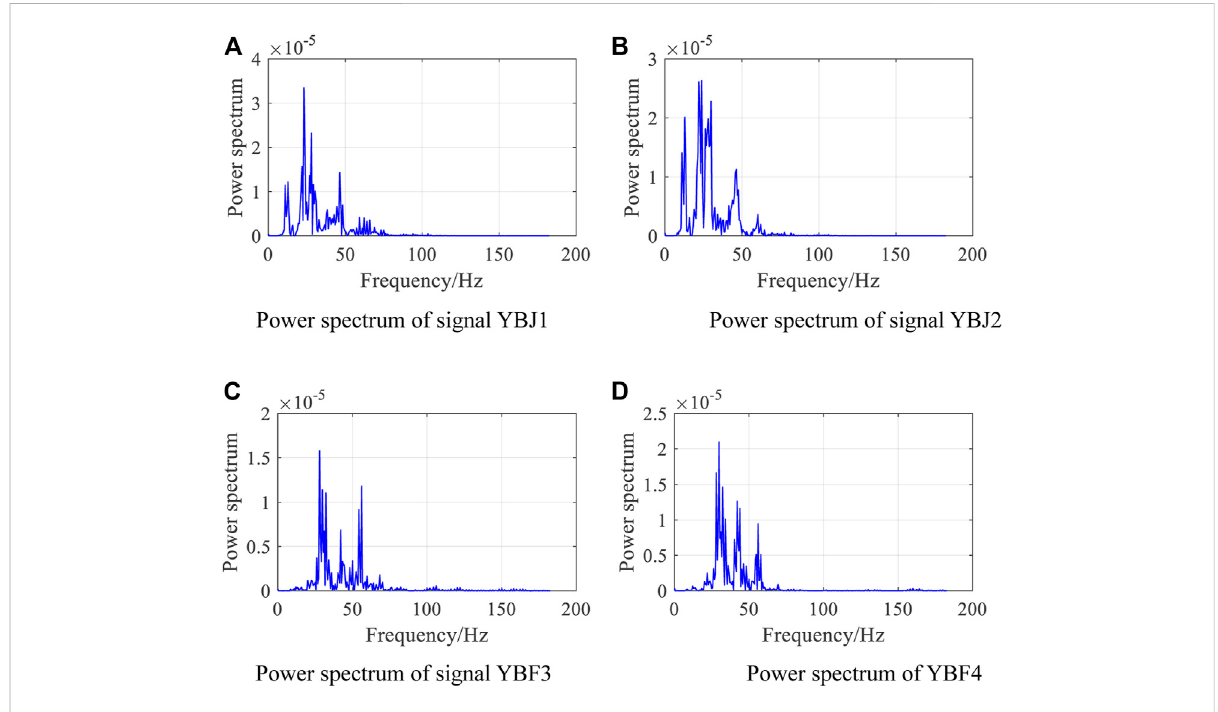
FIGURE 8 Spectrum analysis of different original blasting vibration